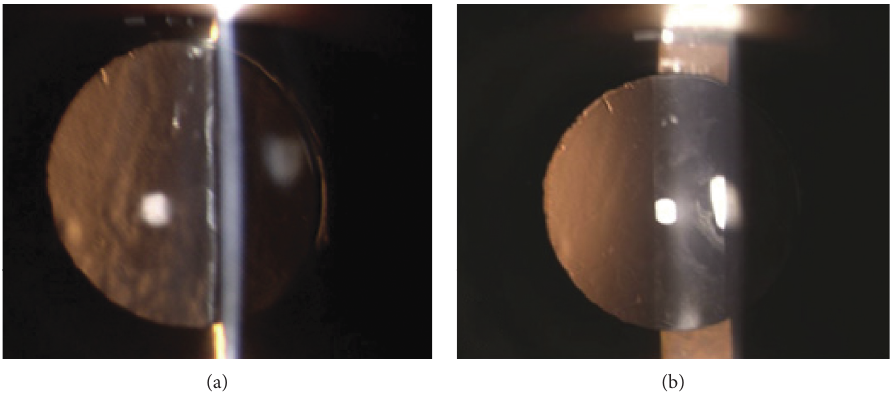
Figure 4: The day after the procedure, slit lamp examination shows complete removal of the fibrotic phimosis and absence of intraocular inflammation (a). After one-year follow-up, anterior capsule opening was unchanged